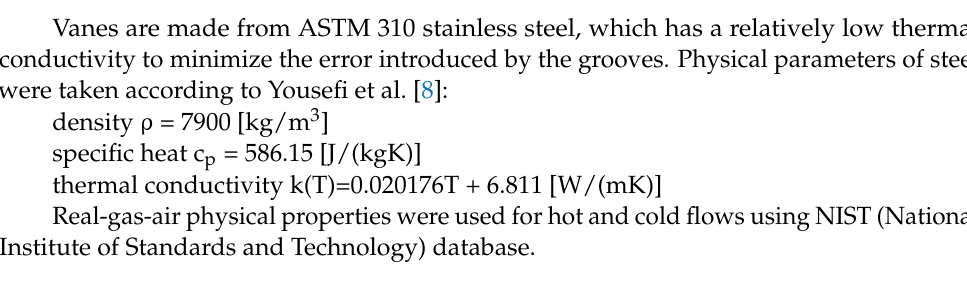
Figure 7. C3X vane input parameters measurement